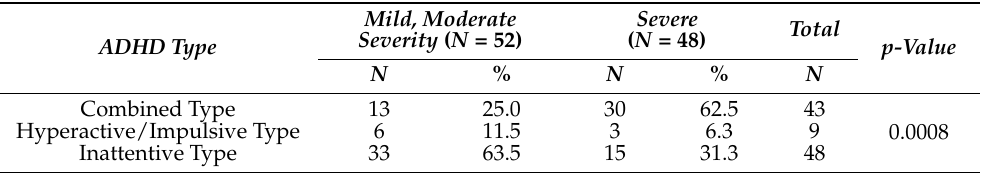
Table 5. Association between ADHD subtype and Severity of ADHD symptoms. ADHD Type